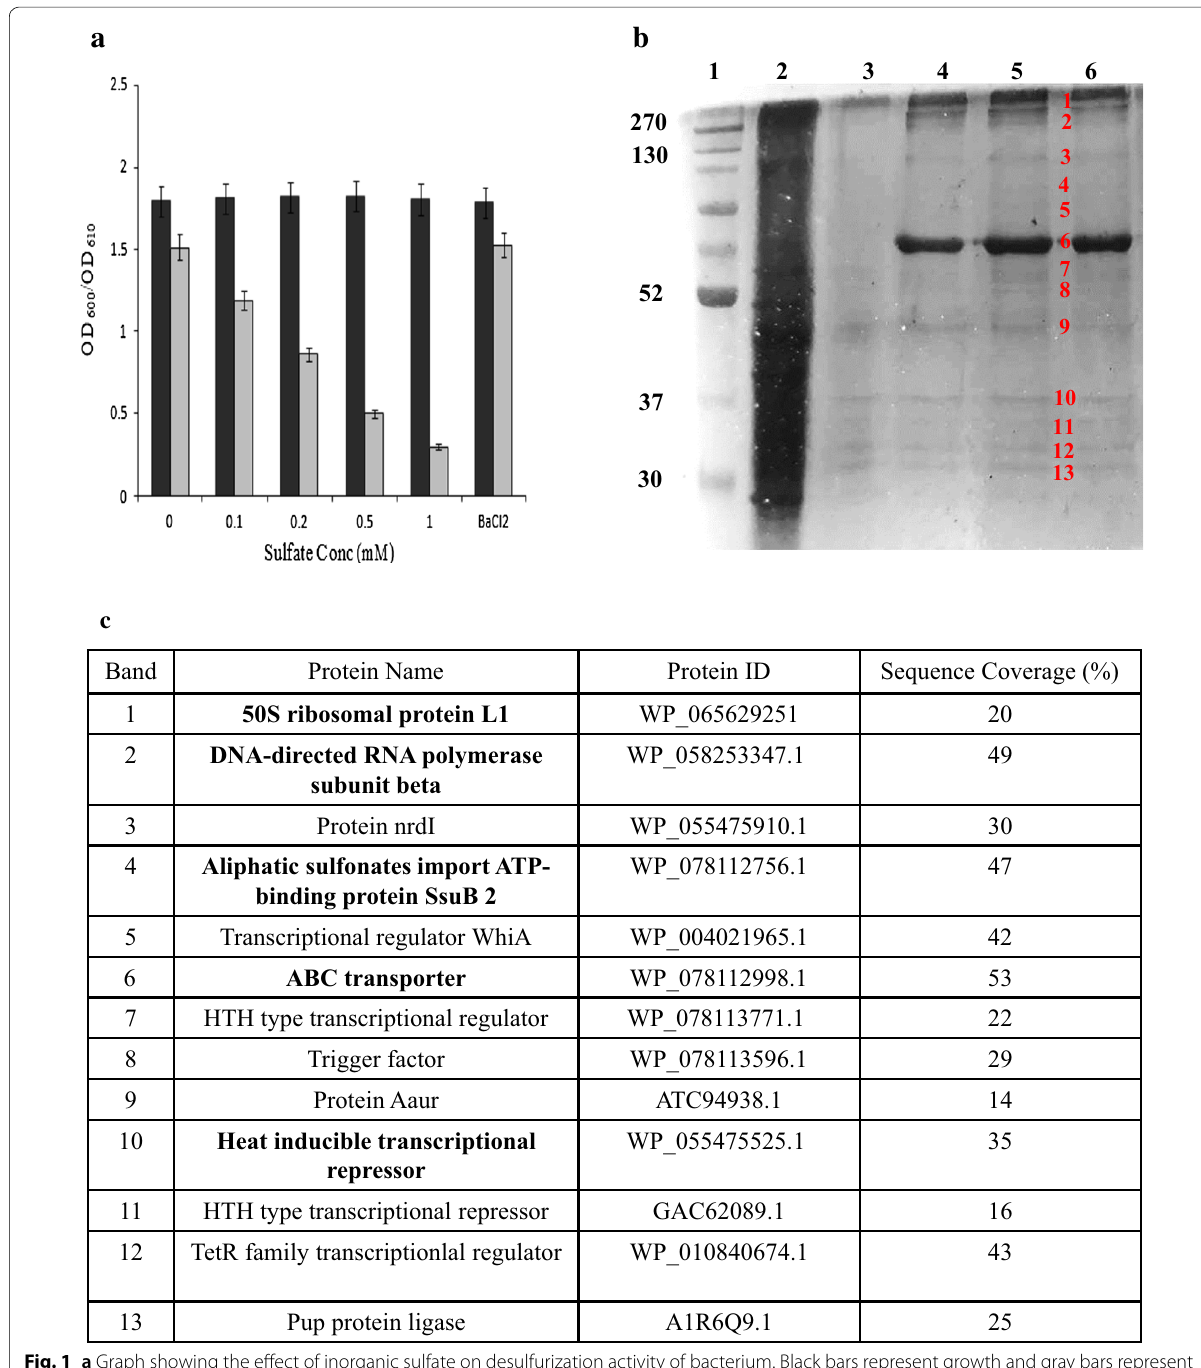
Fig. 1 a Graph showing the effect of inorganic sulfate on desulfurization activity of bacterium. Black bars represent growth and gray bars represent activity of the bacterium, Gordonia sp. IITR100. b A 12% SDS-PAGE gel showing the different fractions in pull down assay with sodium sulfate extract. Lane 1: broad range protein marker lane 2: crude extract, lane 3: flow through from column, lane 4–6: elution fractions. c A table showing the major protein identified corresponding to each band. The proteins marked in bold were common to proteins obtained in pull down assay